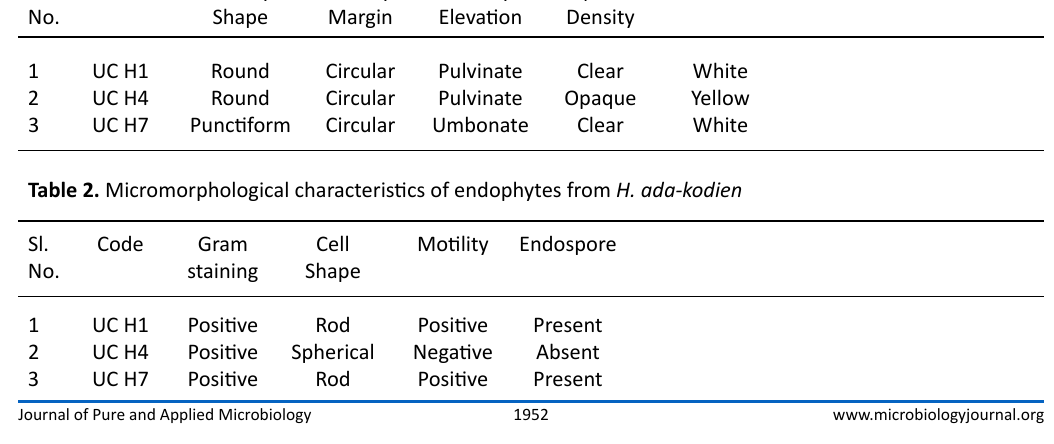
Table 1. Colony characteristics of endophytes isolated from H. ada-kodien Sl. No.